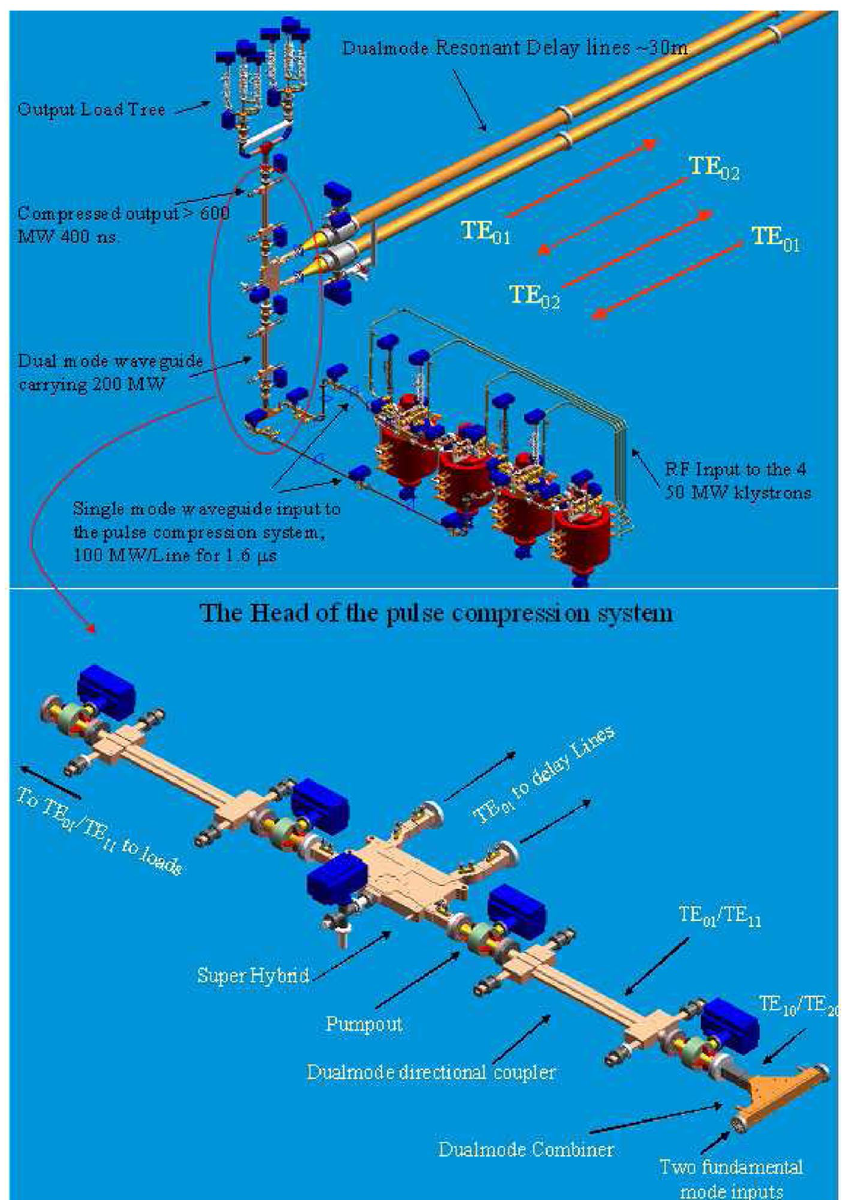
FIG. 19. (Color) Isometric layout of the dual-moded rf system with dual-moded SLED-II pulse compressor.